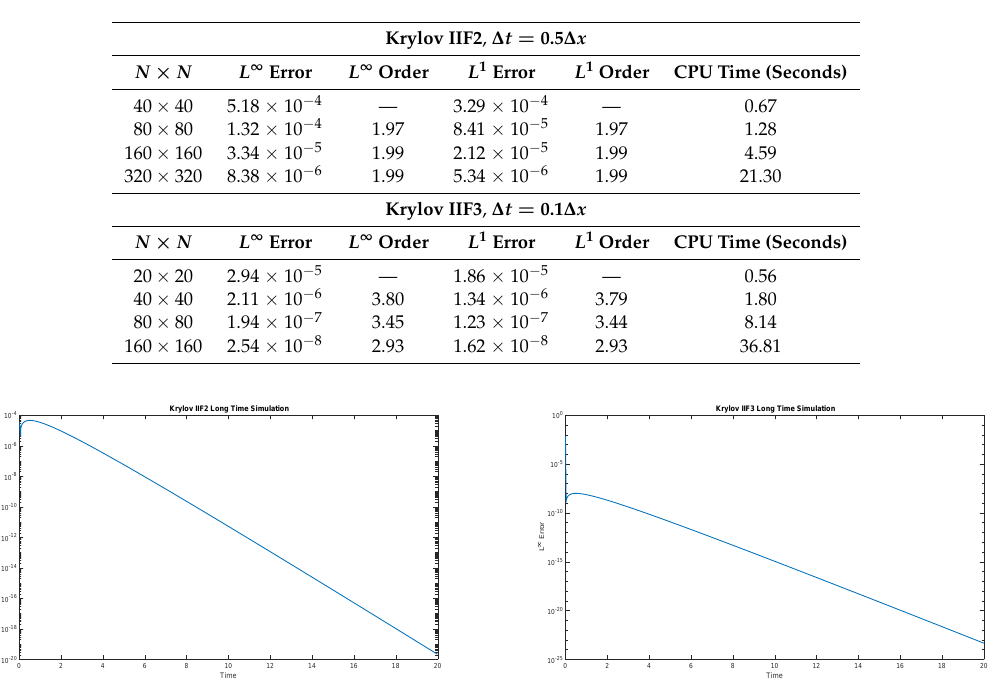
Table 4. Example 4. Fourth-order system with stiff reaction in two-dimensions. CPU time, numerical errors and orders of accuracy of Krylov IIF2 and Krylov IIF3 schemes. Krylov subspace dimension: M = 10; final time: T = 1.0.